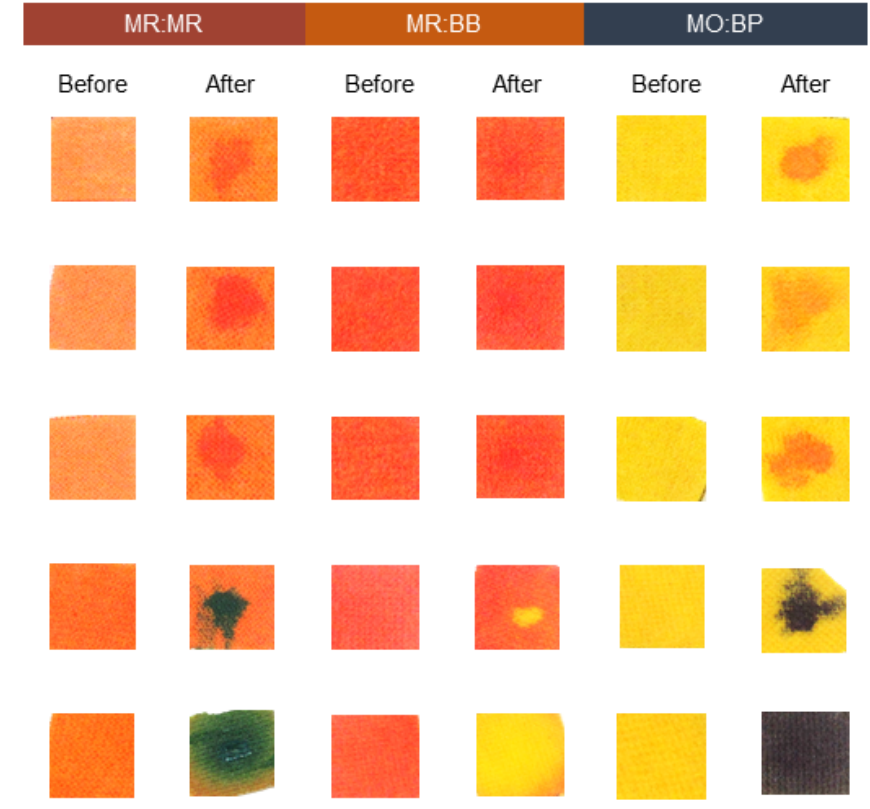
Figure 7. Sensitivity of cotton knits functionalized with different pH sensors, to acidic and basic solutions. The sensors used were: methyl red and bromothymol blue (MR:BB); methyl red and methyl red sodium salt (MR:MR); and methyl orange and bromocresol purple (MO:BP).